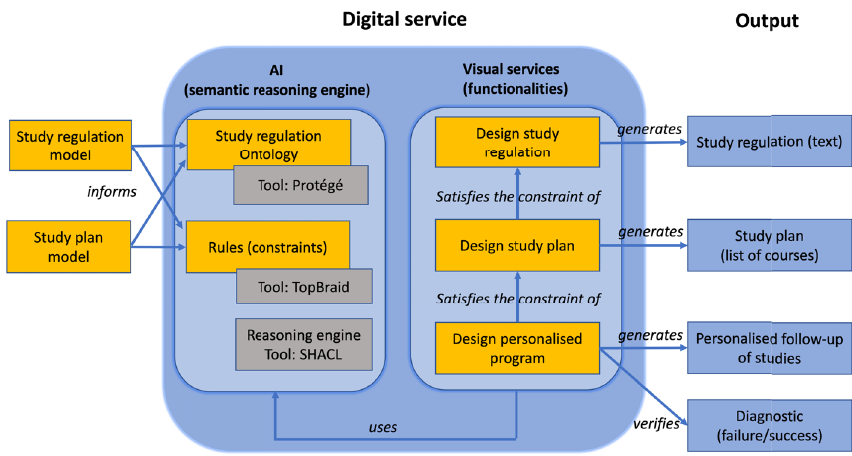
Figure 2: Functionalities /